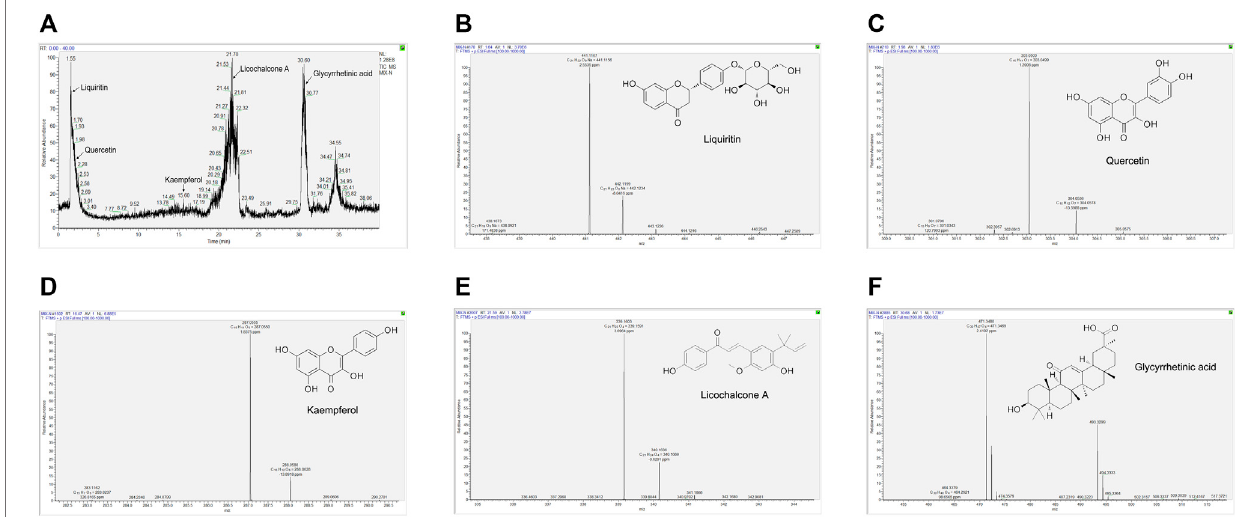
FIGURE 3 | The key ingredients of XBS determined by UPLC-Q/Orbitrap HRMS. Identi fi cation No. (A) The chromatogram of XBS. (B) Liquiritin. (C) Quercetin. (D) Kaempferol. (E) Licochalcone A. (F) Glycyrrhetinic acid.